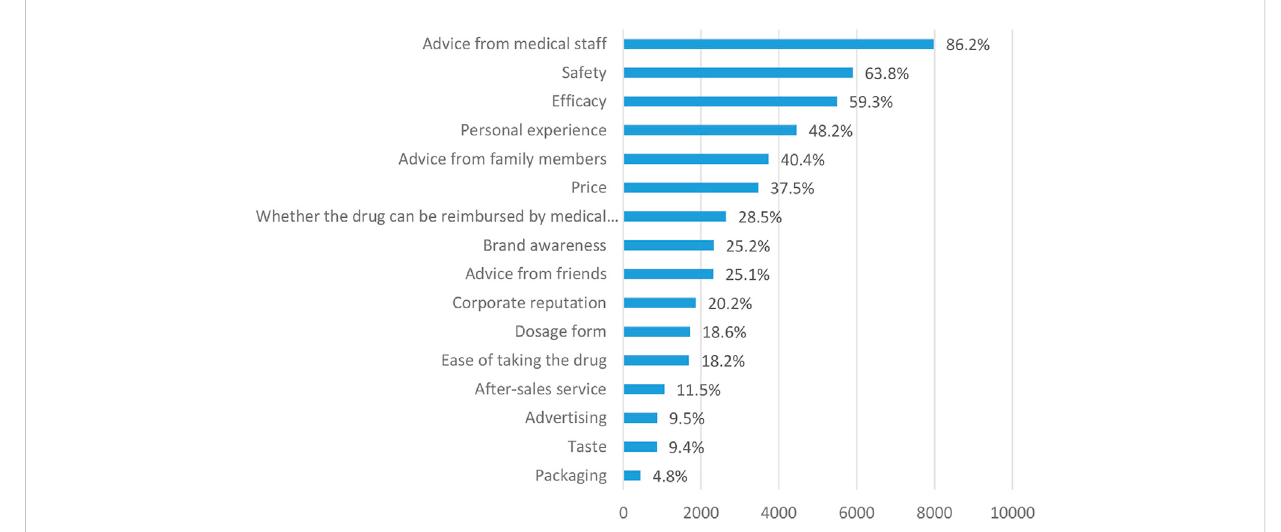
FIGURE 3 Important considerations when respondents purchase OTC drugs.